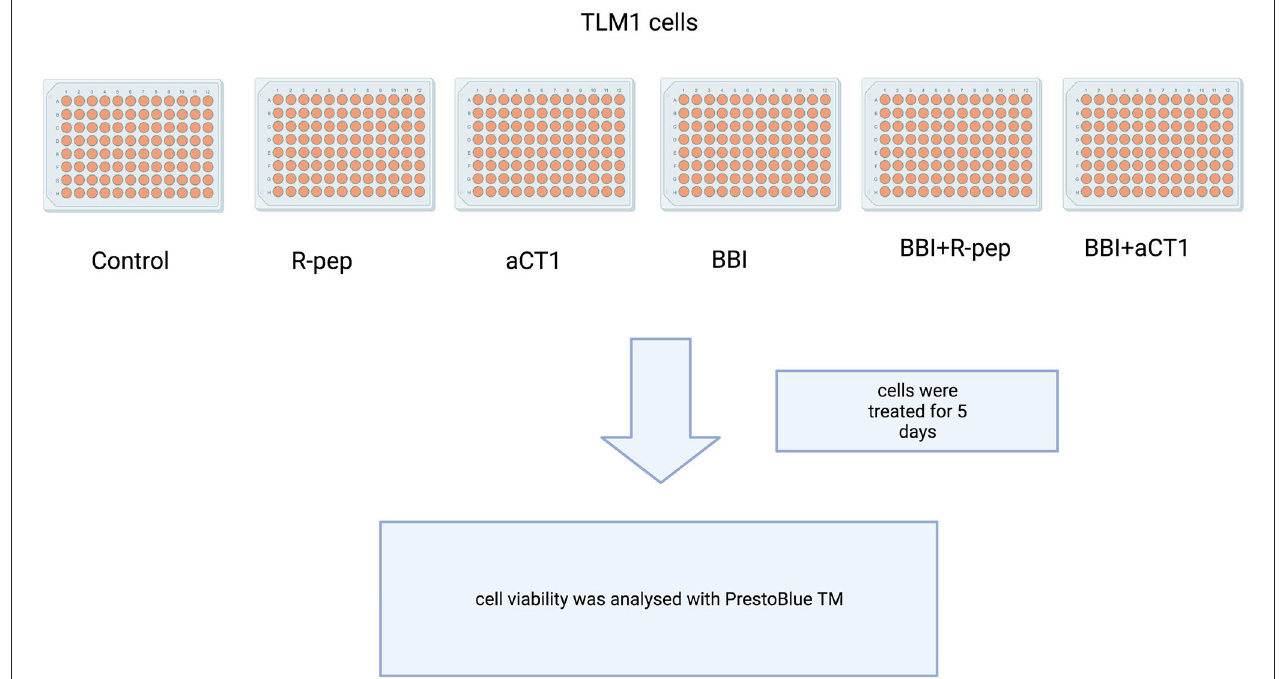
FIGURE 1 | Scheme of TLM1 cells treatment with aCT1, BBI, BBI + R-pep, and BBI + aCT1, R-prep or control.